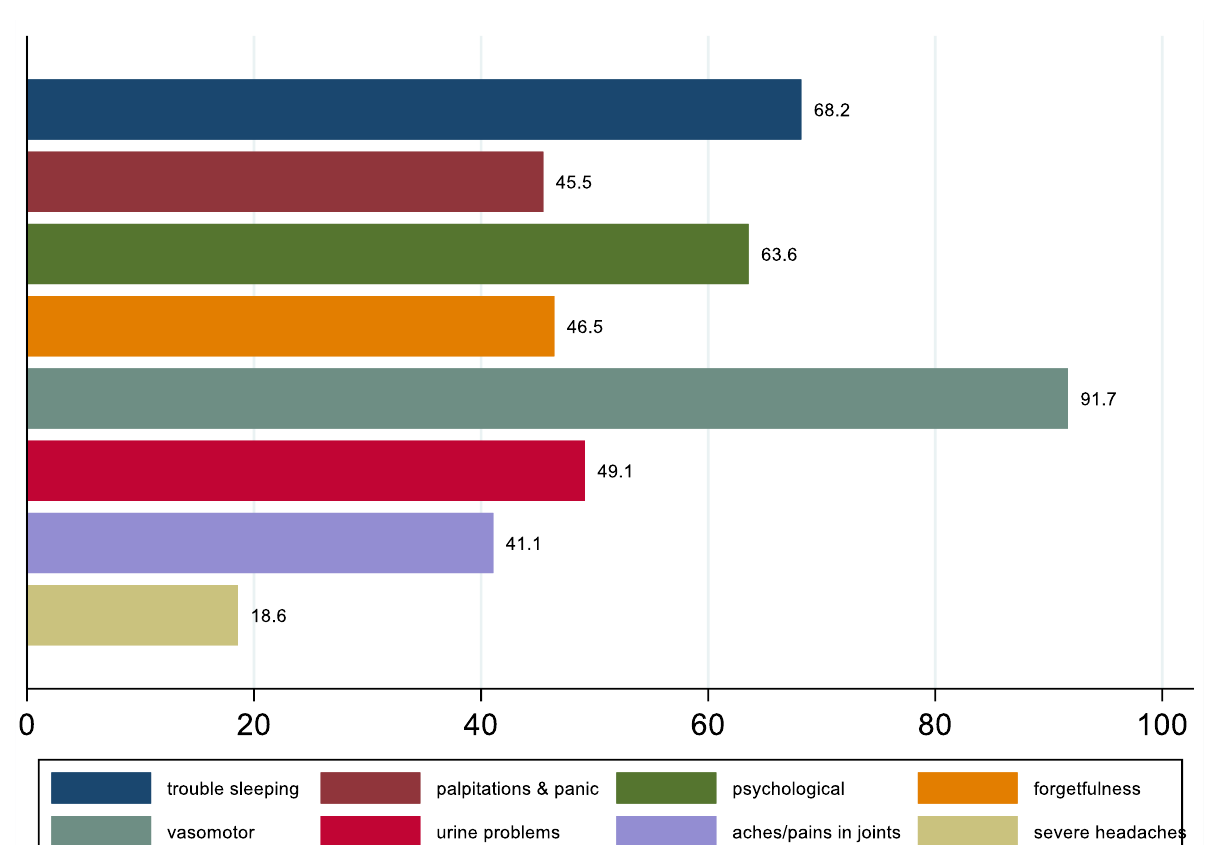
Figure 1. Prevalence of different types of menopausal symptoms among a population sample of 409 women who were working during their menopause.